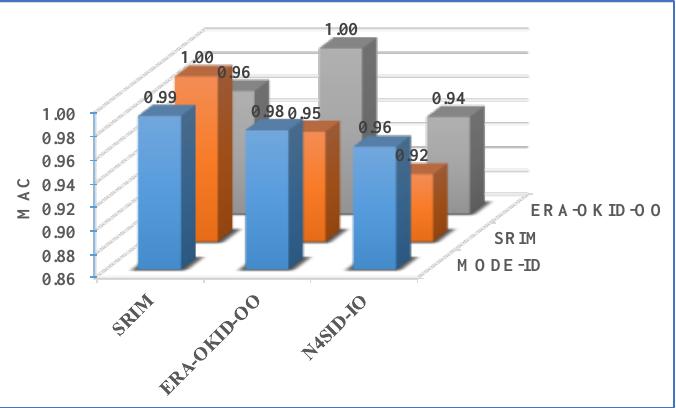
Figure 10. Comparison between the first-order symmetric vibration modes identified by San Fer- nando seismic monitoring in 2001 using different methods. seismic monitoring in 2001 using different